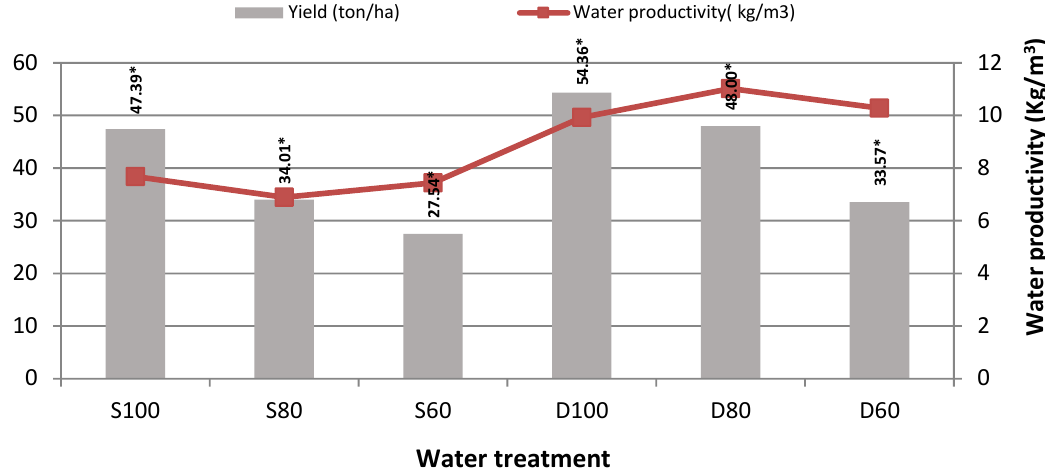
Figure 4. Effect of different irrigation and water treatments on bunch weight, total yield fruit and flesh weight of date palm. Significant differences *, Non-significant **, (ha): Hectare, WP: Water productivity, M 3 : Quebec meter.